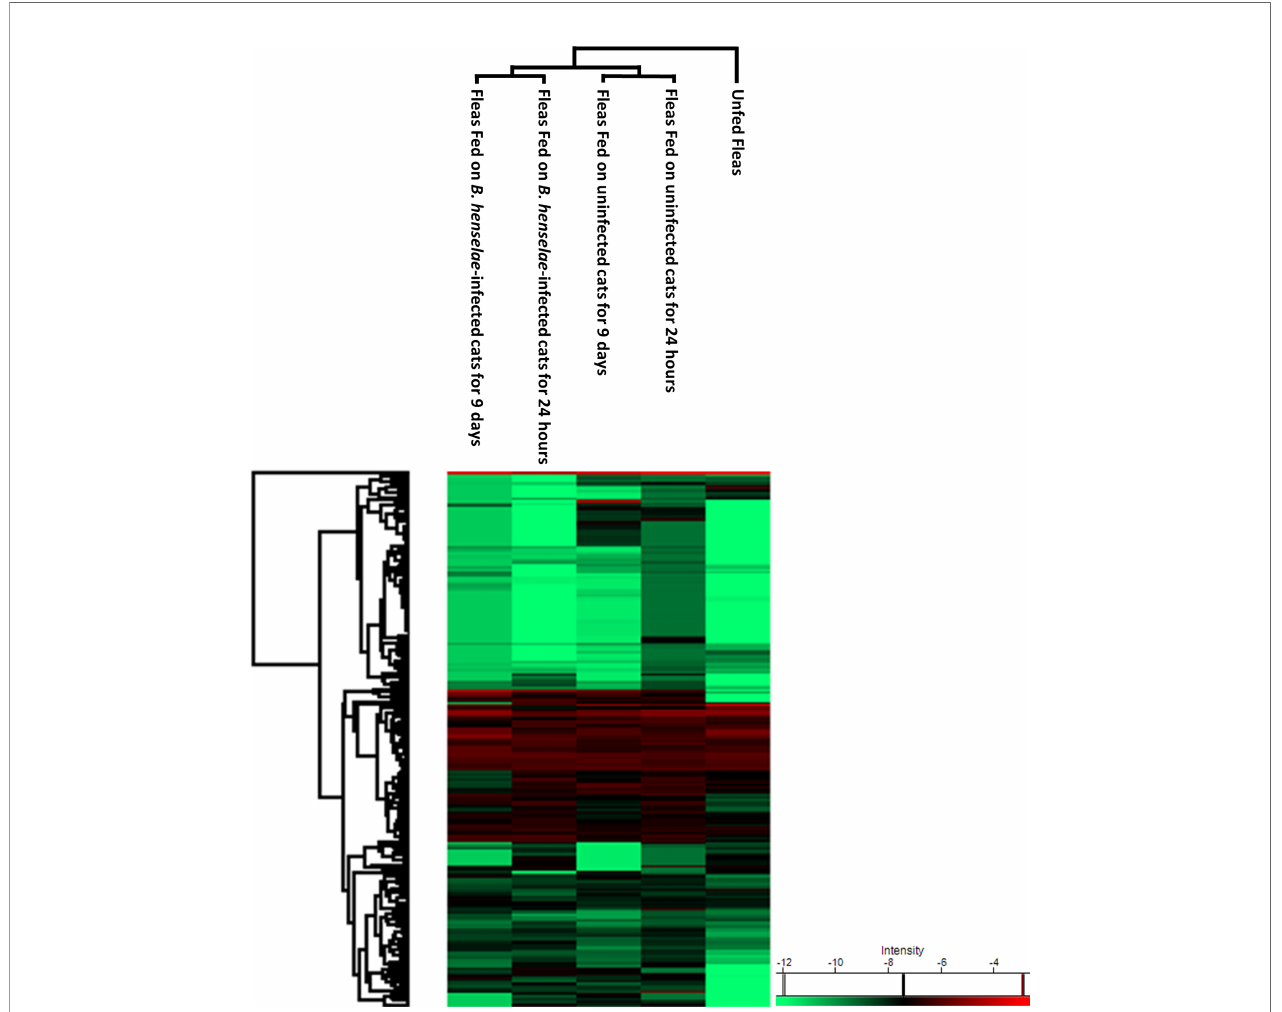
FIGURE 3 | Heat map of all identi fi ed proteins in the present study (unfed fl eas, fl eas fed on uninfected cats for 24 hours and 9 days, and fl eas fed on B. henselae - infected cats for 24 hours and 9